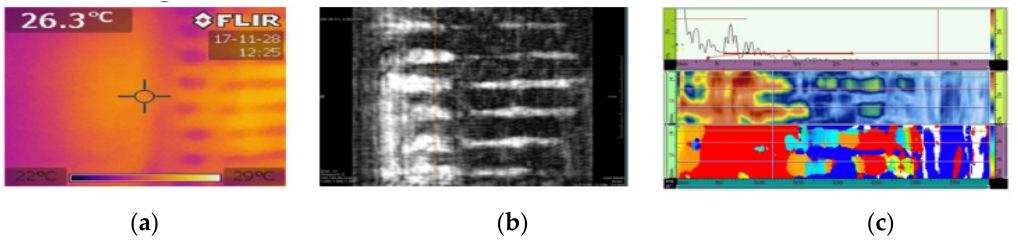
Figure 22. Non-destructive sensor feedback from a rotor blade section: thermography ( a ); radar ( b ), ultrasonic ( c ).